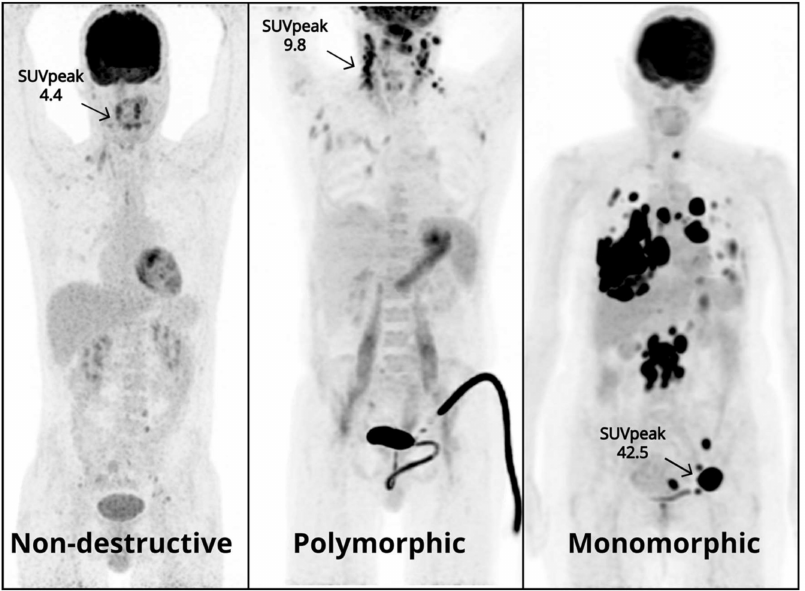
Figure 4. Representative PTLD patient for each morphological subtype with SUV peak at biopsy